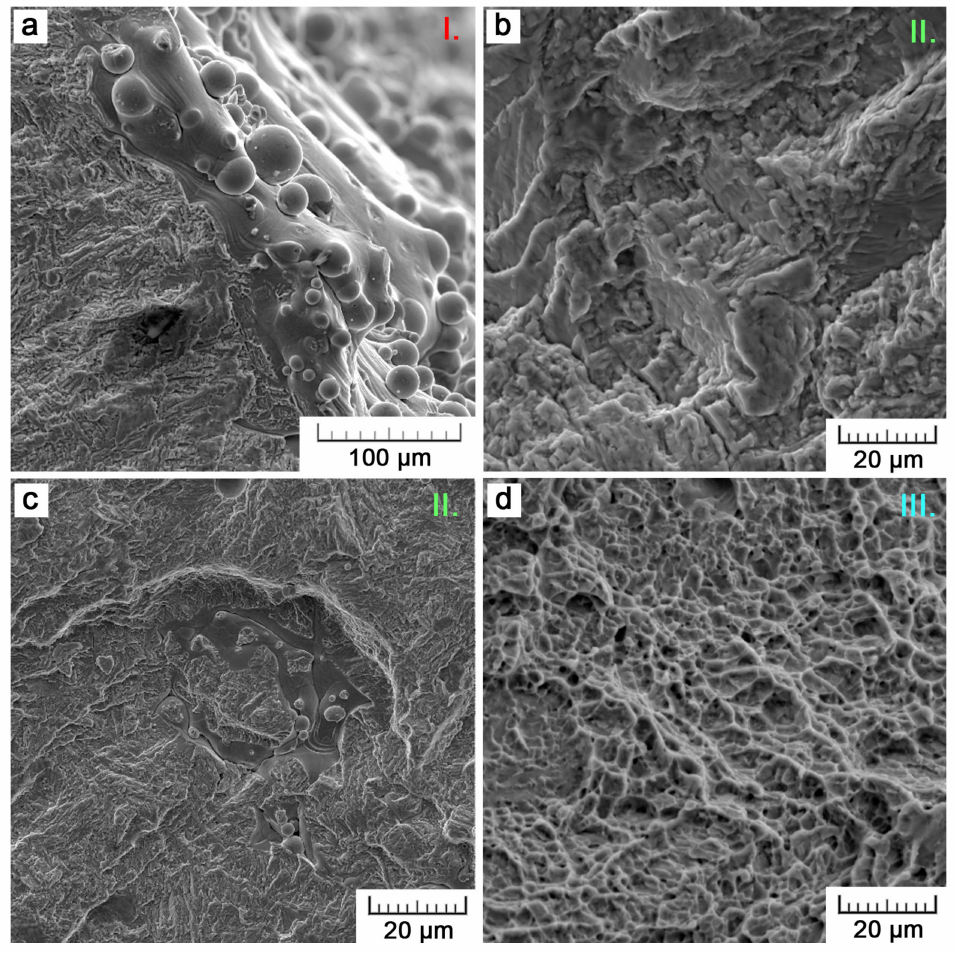
Figure 10. Details of the fracture surface of the SLM fatigue specimen: ( a ) initiation site (area I.); ( b ) crack propagation (area II.); ( c ) defect; ( d ) final fracture (area